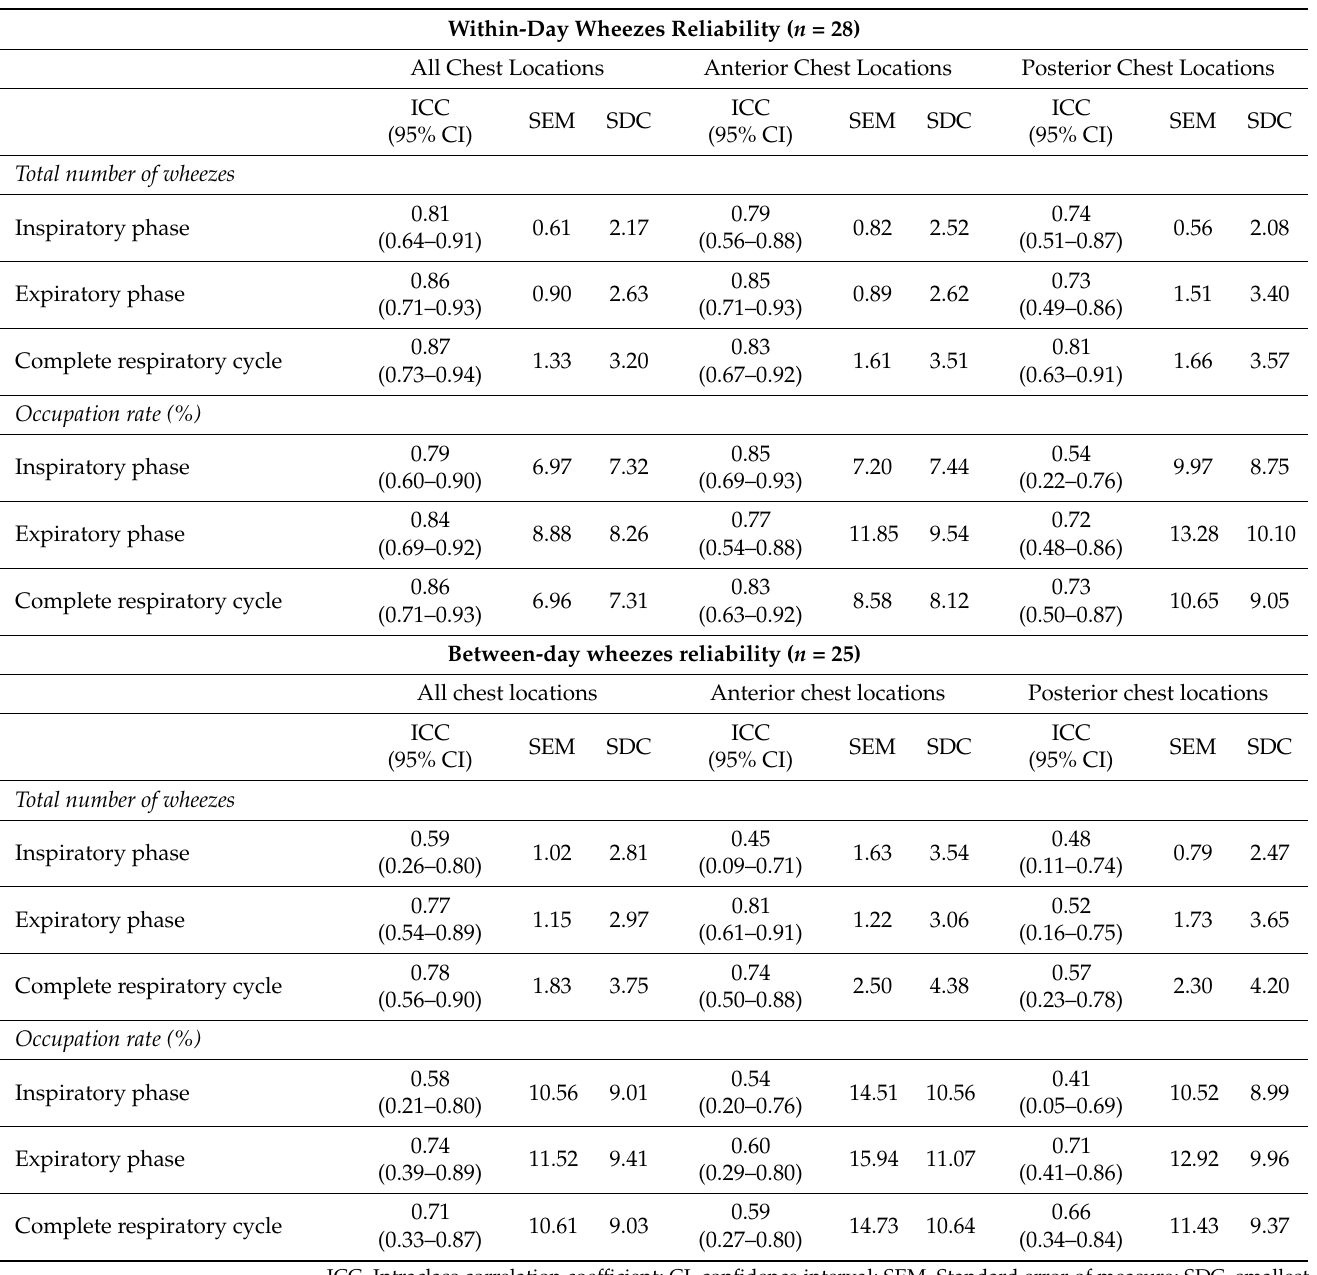
Table 4. Within-day and between-day reliability of wheezes during the inspiration, expiration and complete respiratory cycle and per chest